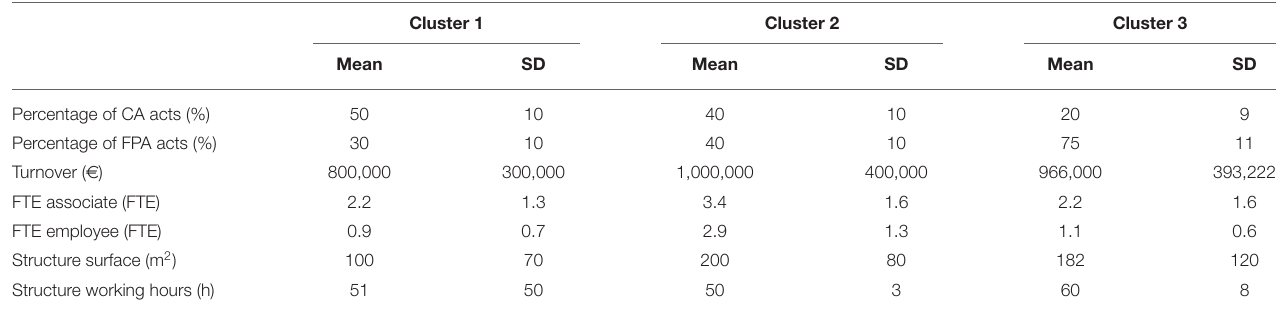
TABLE 5 | Characteristics of the clusters of veterinary practices obtained with the PCA and the consolidated